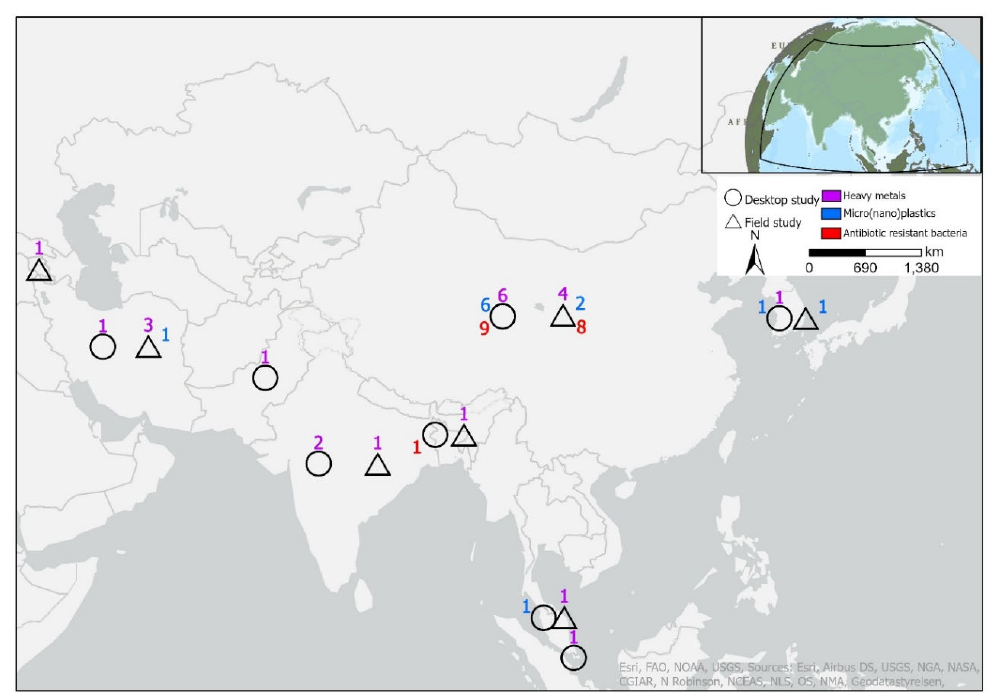
Figure 2. Asia: Number of studies on heavy metals, micro(nano)plastics, and antibiotic-resistant bacteria considered in our review, per country. Field studies were counted for the country where the analysis was performed, desk studies were counted for the country of the first author’s institution.